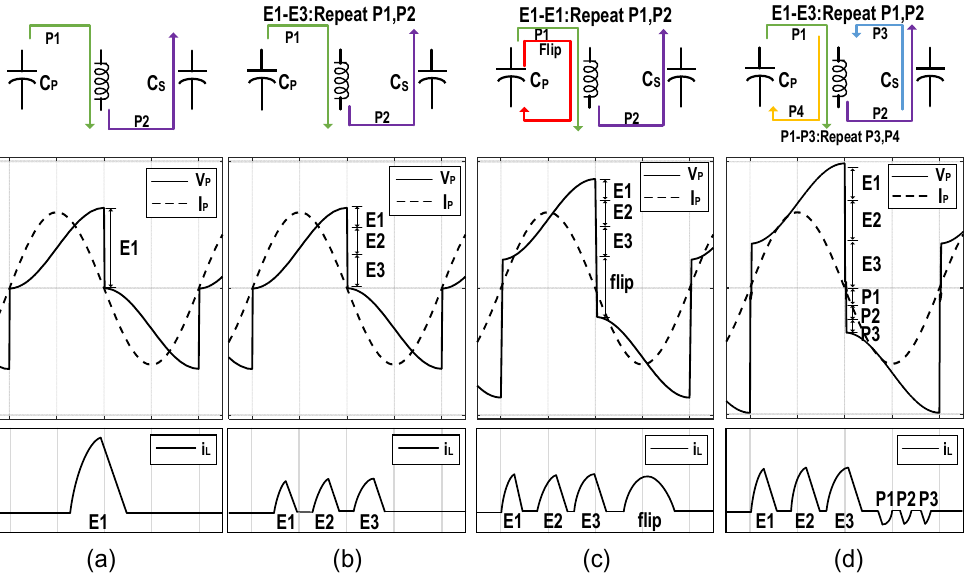
Figure 11. Schematic diagrams of energy transferred path and waveforms of V P , I P , and i L for ( a ) the SECE, ( b ) the MCE, ( c ) the MCEBF and ( d ) the MCE-MPC interface.